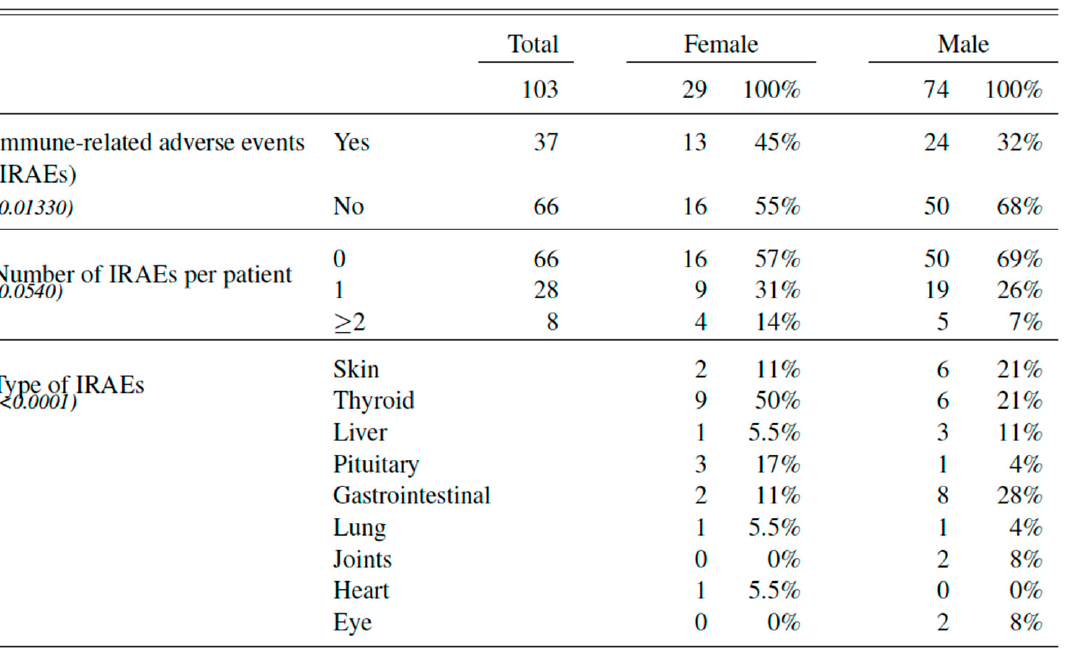
Figure 3. Immune-related adverse events in male and female patients with advanced melanoma treated with ICI.